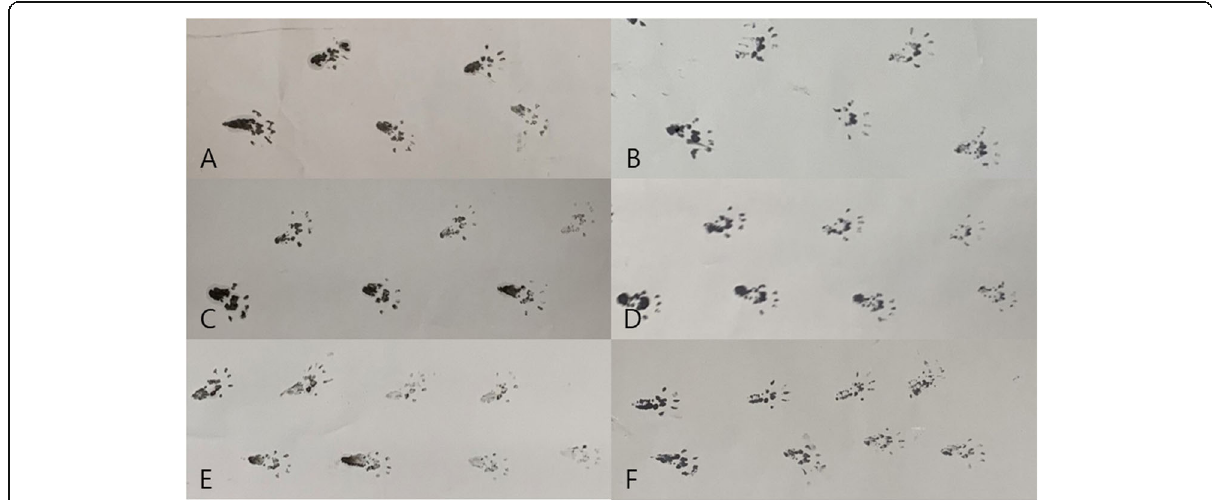
Fig. 4 Walking track analysis. A Footprints of group A at 2 weeks. B Footprints of group A at 4 weeks. C Footprints of group B at 2 weeks. D Footprints of group B at 4 weeks. E Footprints of group C at 2 weeks. F Footprints of group C at 4